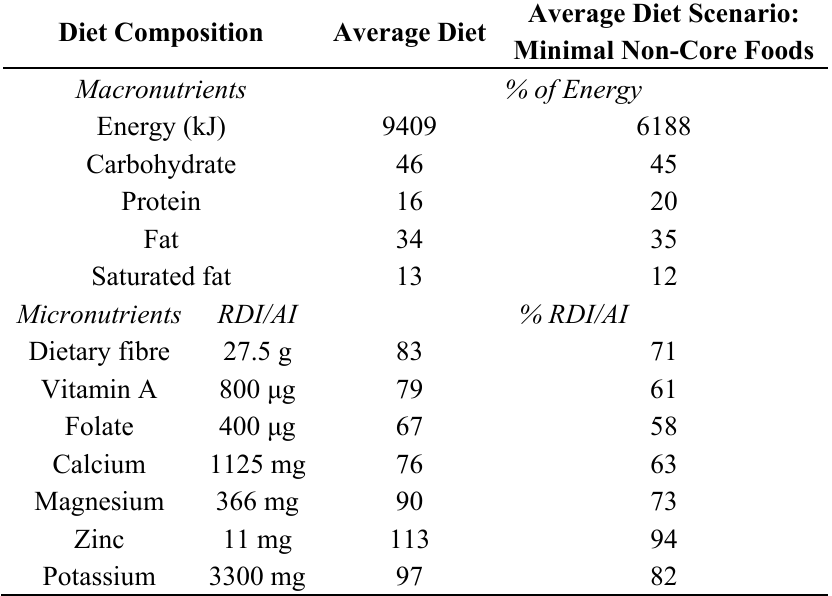
Table 2. Macro and micronutrient adequacy 1 of the diet scenarios, expressed as a percentage of total energy or a percentage of the dietary